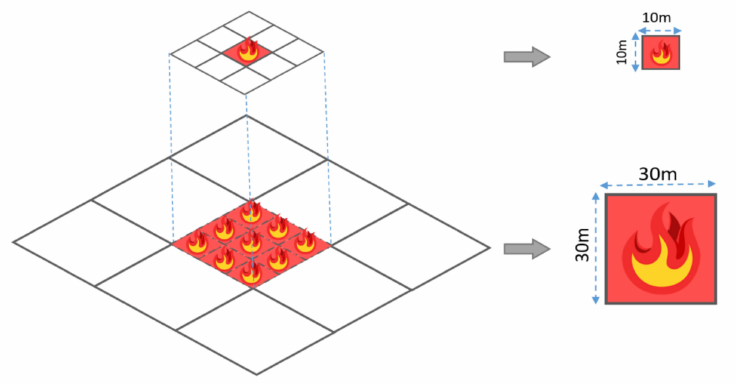
Figure 3. Illustration of converting a wildfire location (point) into a raster with different pixel sizes of 10 m and 30 m spatial